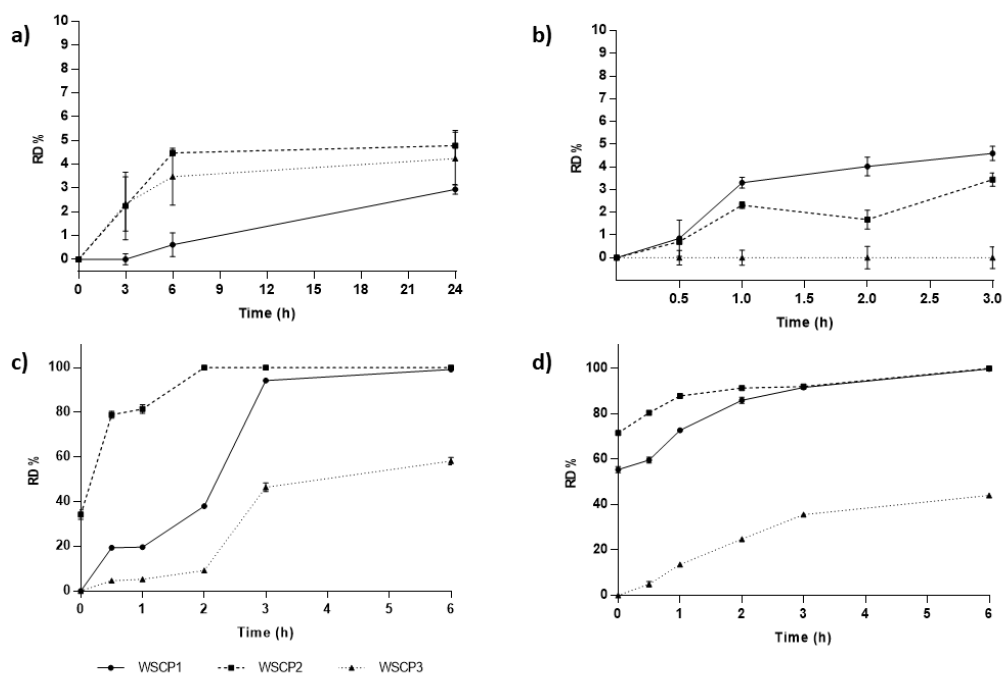
Figure 2. Relative difference (RD%) of prodrugs conversion over time in ( a ) water and different buffer media at pH ( b ) 1.2, ( c ) 6.8, and ( d ) 7.4. Values are the means of three experiments and error bars represent the standard deviation. Table 1. The first-order dissociation rate constants (K obs ) and half-live times (t 1/2 ) of WSCP1-3 at pH 6.8 and 7.4 buffers.